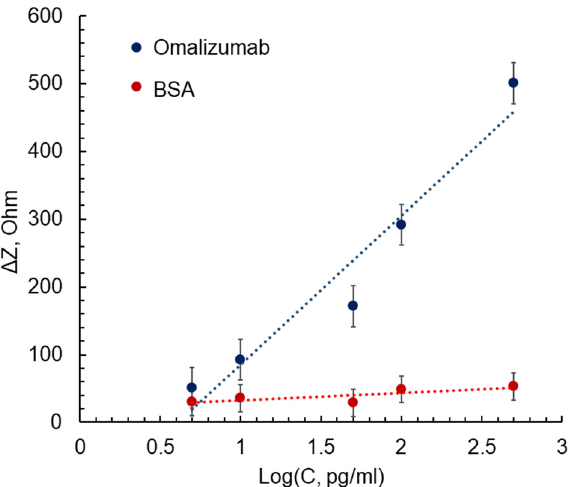
Figure 12. Dependences of the impedance change at a frequency of 10 kHz on the logarithm of the concentration of omalizumab (blue line, y = 220.11 x − 134.87, R 2 = 0.9421) and BSA (red line, y = 11.096 x + 21.432, R 2 = 0.6464).